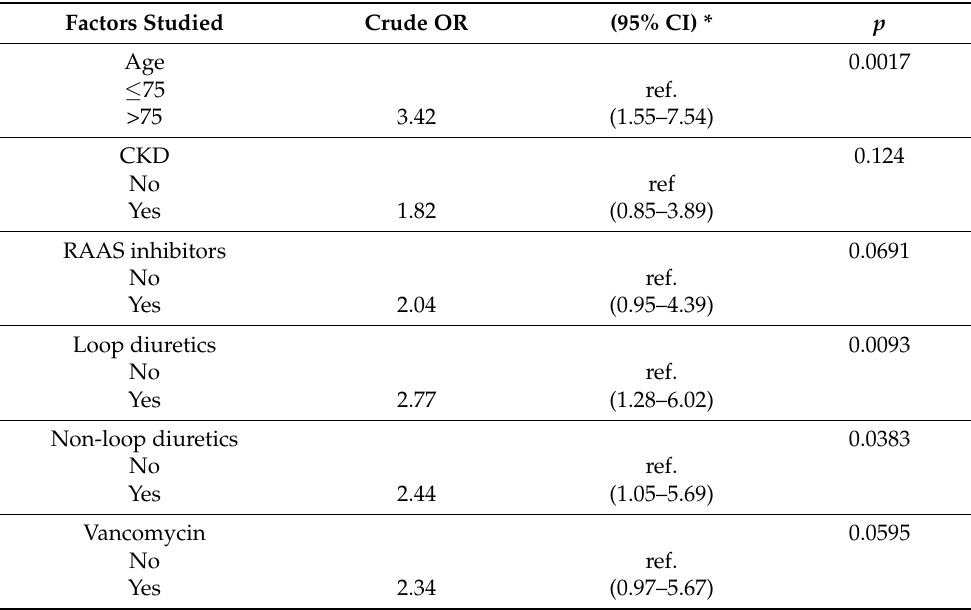
Table 3. Univariate analysis of factors associated with AKI in the CLOX-AKI study (only factors included in the multivariate analysis are